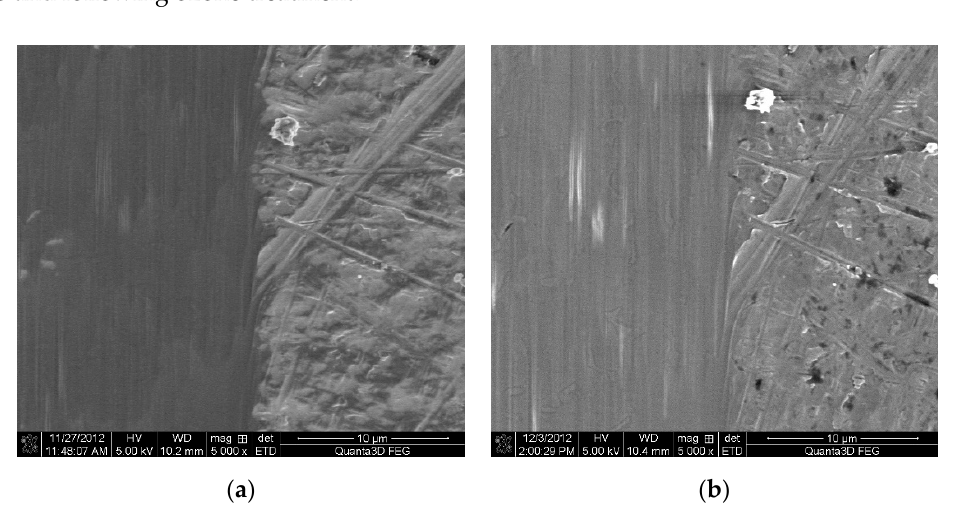
Figure 5. Topography of Ti6Al4V titanium alloy surface after ionic polishing with FIB (focus ion beam) technique: ( a ) Before ozone treatment; ( b ) after ozone treatment (samples after ozone treatment: 50 g O 3 /m 3 for 45 min ).